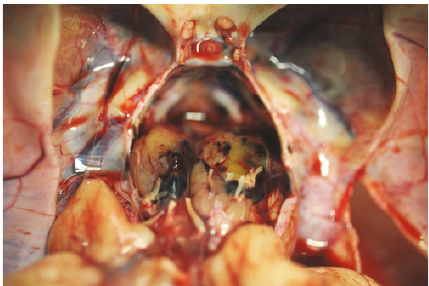
Figure 2: Upon opening the skull the brainstem was obscured by a large tumor with variegated appearance, soft somewhat gelatinous consistency, showing multiple hemorrhagic areas. (Brain is reflected posteriorly to expose the posterior cranial fossa; sella turcica with pituitary gland and transected optic nerves are seen at mid upper portion of the photograph.)